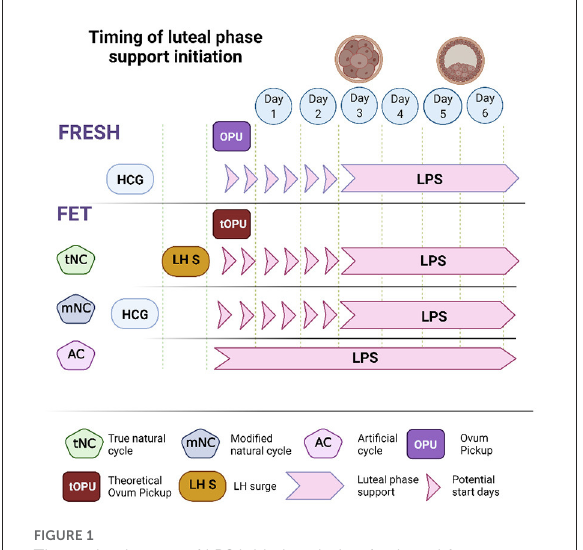
FIGURE1 The optimal range of LPS initiation during fresh and frozen embryo transfer. In fresh cycles the optimal range of LPS initiation was defined as day of OPU and up to 3 days later. In frozen transfers, the start of LPS depends on the presence of a corpus luteum (CL). In artificial cycles that take place in the absence of a CL, the transfer of a day 3 embryo and a blastocyst should be performed on the 4 th and 6 th days of LPS, respectively. In natural and modified natural FETs we refer to a theoretical OPU to standardize the optimal range of LPS initiation. Embryo transfer should be performed 1 day sooner following an LH surge in a tNC, compared to hCG trigger in a mNC.